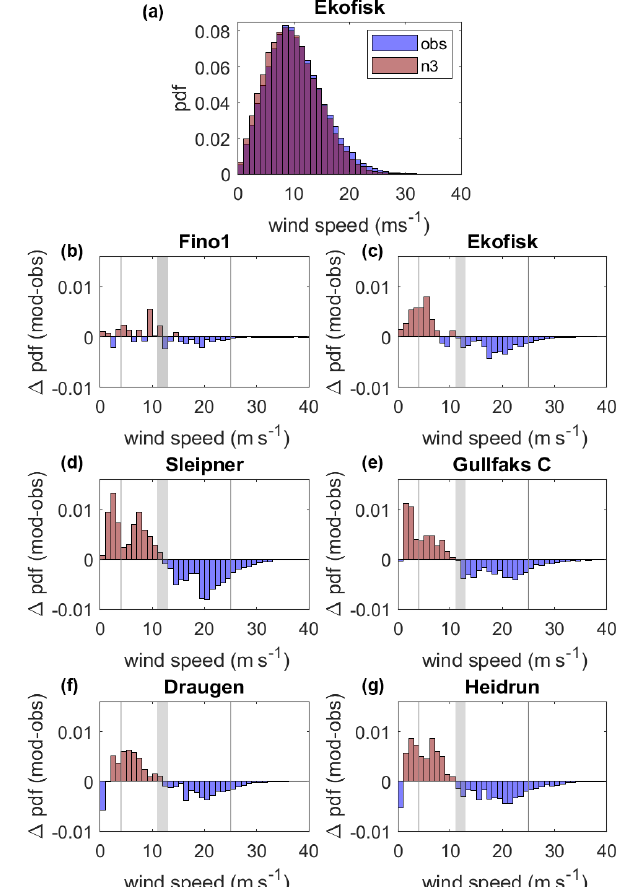
Figure 3. (a) Example wind speed probability density func- tion (pdf) (Ekofisk) for NORA3 (n3) in red and observations (obs) in blue. (b–g) Differences between NORA3 and observational wind speed probability density functions ( (cid:49) pdf = pdf mod − pdf obs ) for the six sites. When (cid:49) pdf = 0 . 01 the probability that the given wind speed will occur is 1% higher in the model output. The large gray area corresponds to the range within which the rated wind speed usually falls. The gray vertical lines at the left and right mark the cut-in and cut-out wind speed limits used in this study, respectively.